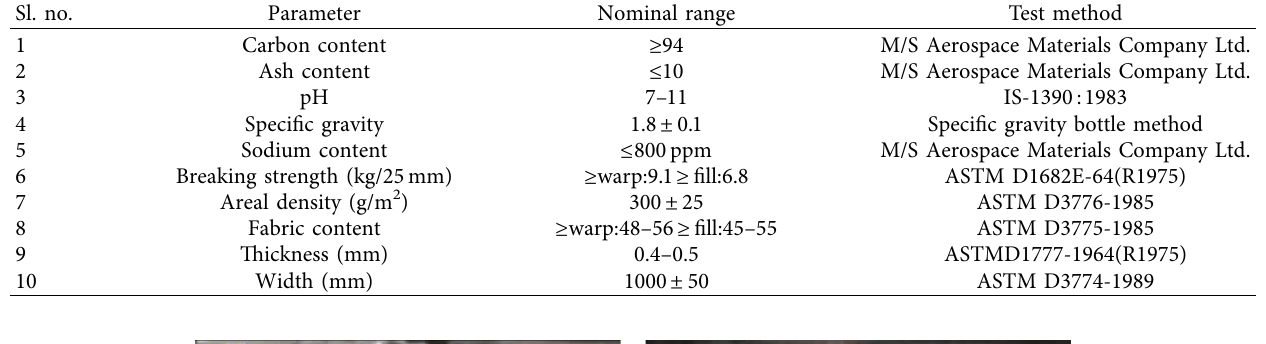
Table 2: Specification of rayon-based carbon fabric.